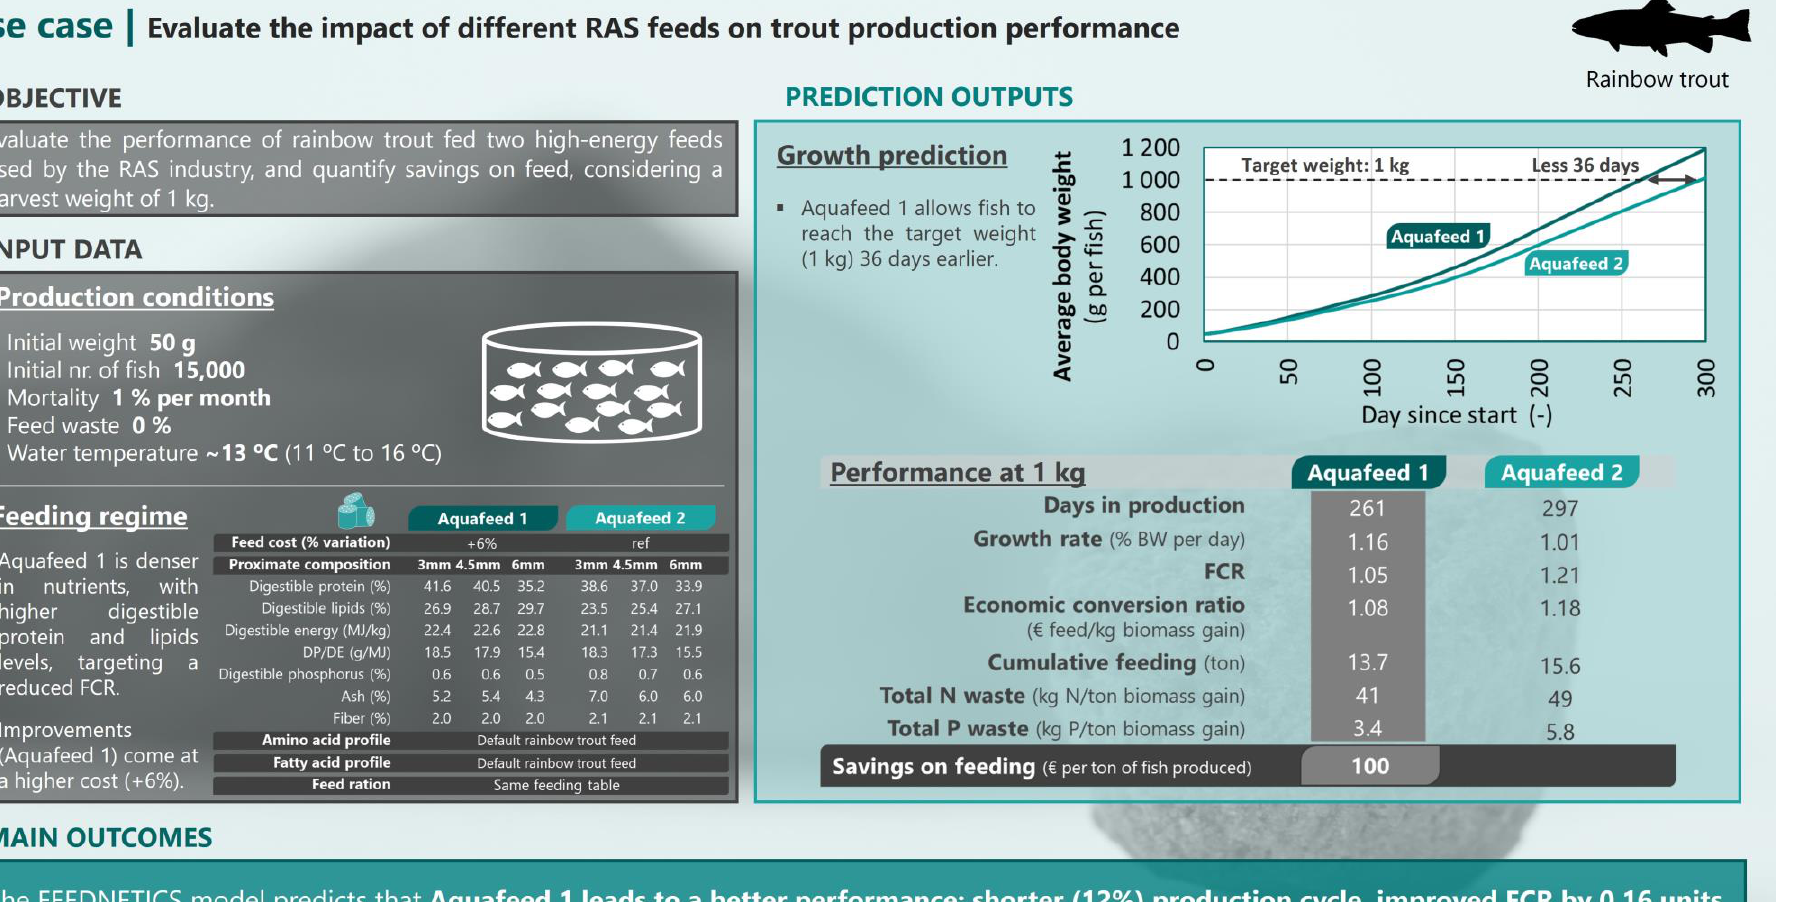
Figure A4 Use case 1: Evaluate the impact of different RAS feeds on trout production performance. All results are FEEDNETICS model predictions.